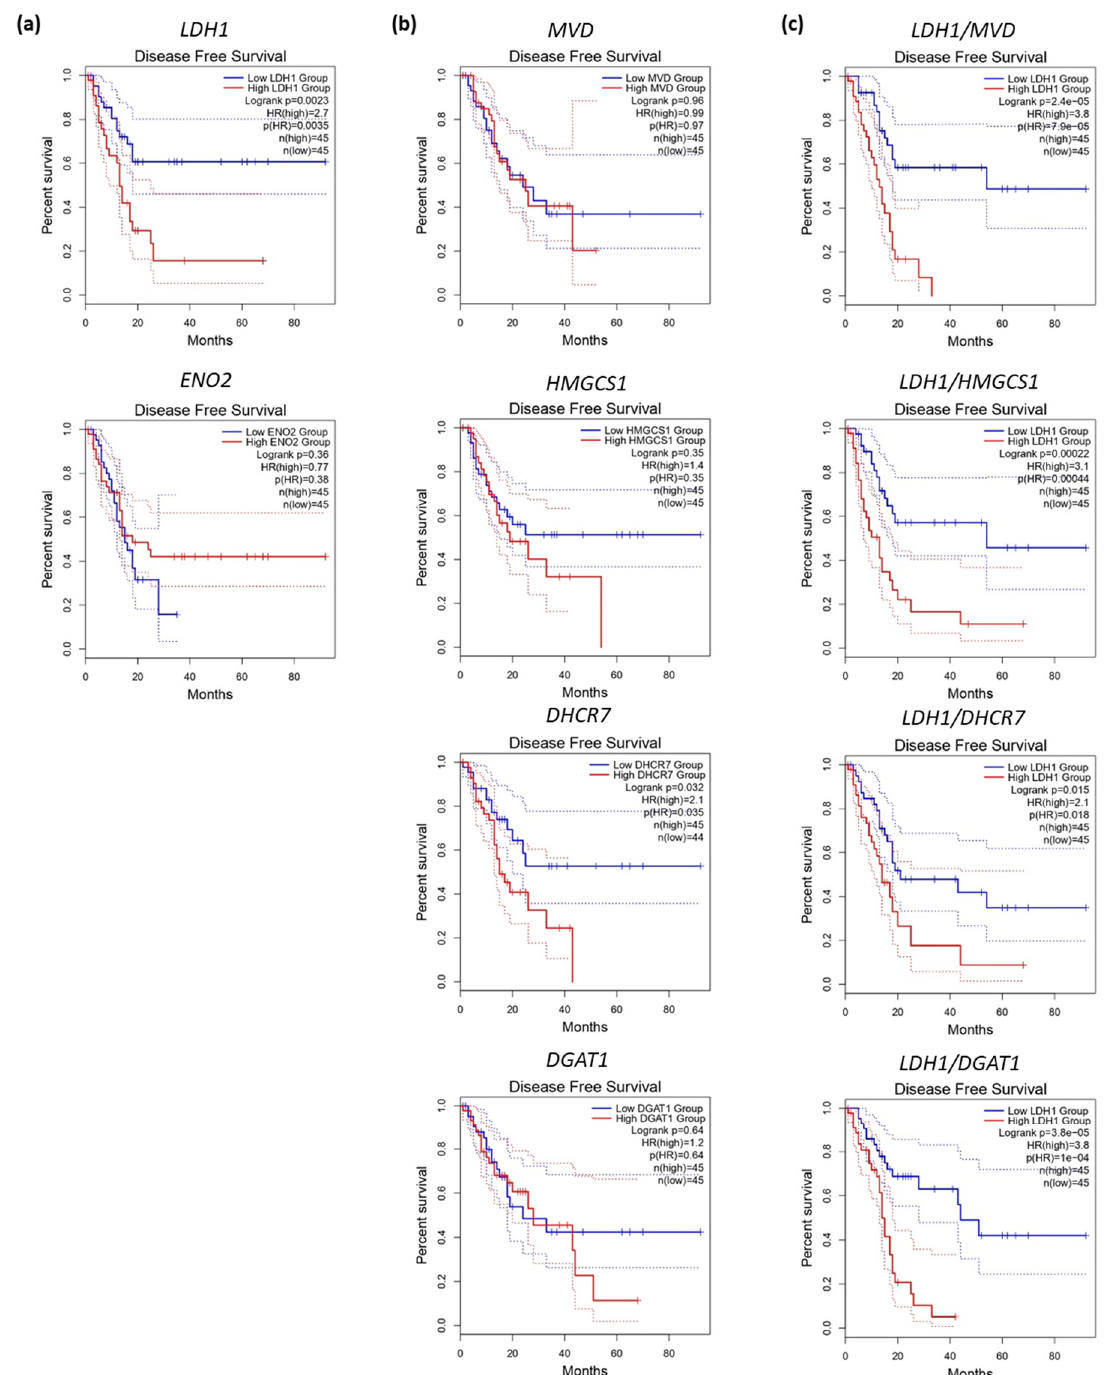
Figure 2. Disease-free survival analysis based on the expression of the genes selected for di ff erent metabolic classification systems. ( a ). LDH1 and ENO2 . ( b ) MVD , HMGCS1 , DHCRT and DGAT1 . ( c ) Ratio LDH1 and MVD , HMGCS1 , DHCR7 or DGAT1 . Comparison of upper and lower population quartiles is displayed. Log-rank test, Hazard Ratio (HR) and their corresponding p -values were calculated based on the COX model. Analyses were performed using the GEPIA2 web tool (http: // gepia2.cancer-pku.cn) using public gene expression information collected in the TCGA